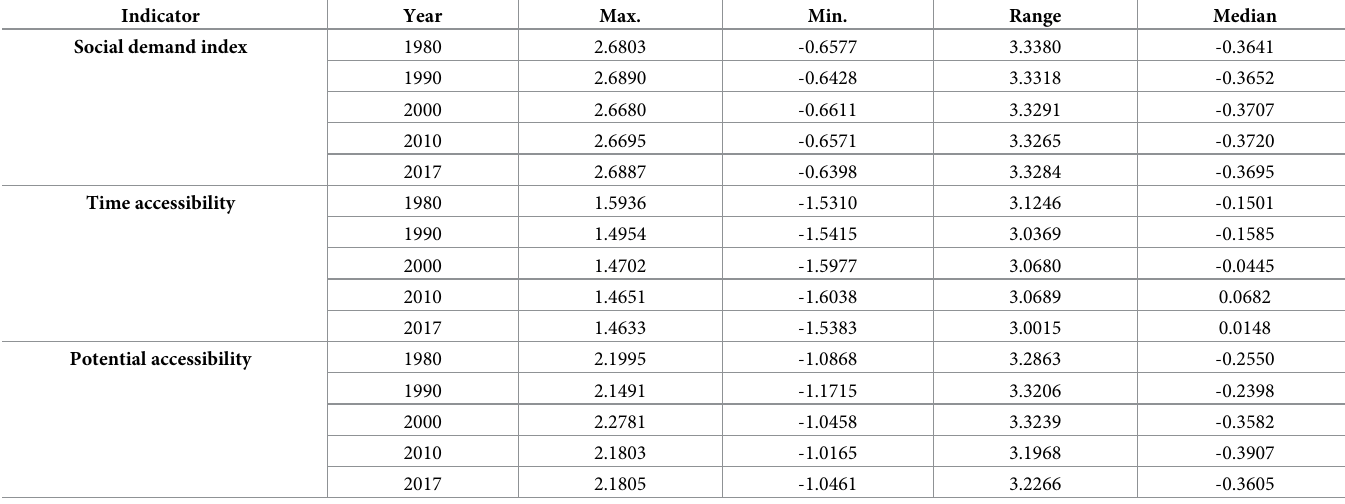
Table 3. Normalised values of the